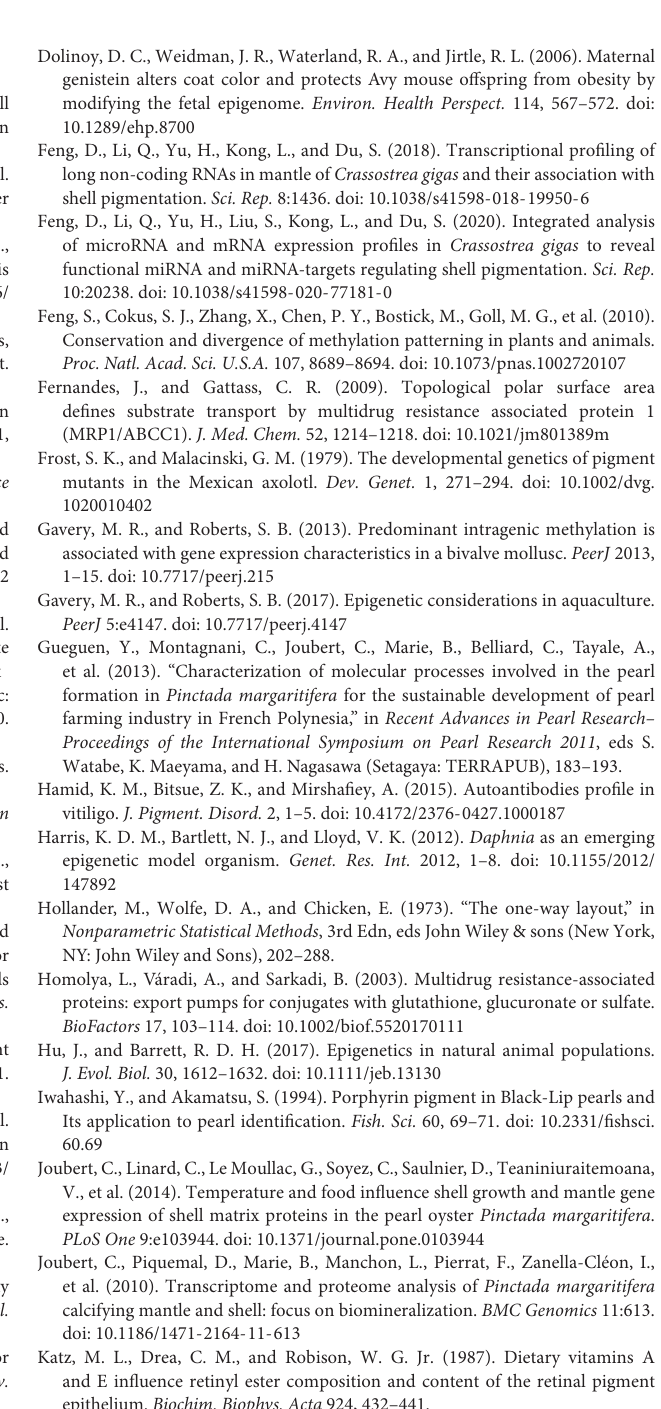
CHG, CHH or in unknown contexts, and the basic statistics of the gene body methylation rate (GBM – on the 54408 genes of the reference genome). Supplementary Table 3 | All significantly differentially methylated positions ( q value < 0.05) for the controls. Scaffold name: scaffold number; Scaffold size: scaffold size; Position: position of the significantly differentially methylated positions on this scaffold; Genomic element: the genomic feature containing the